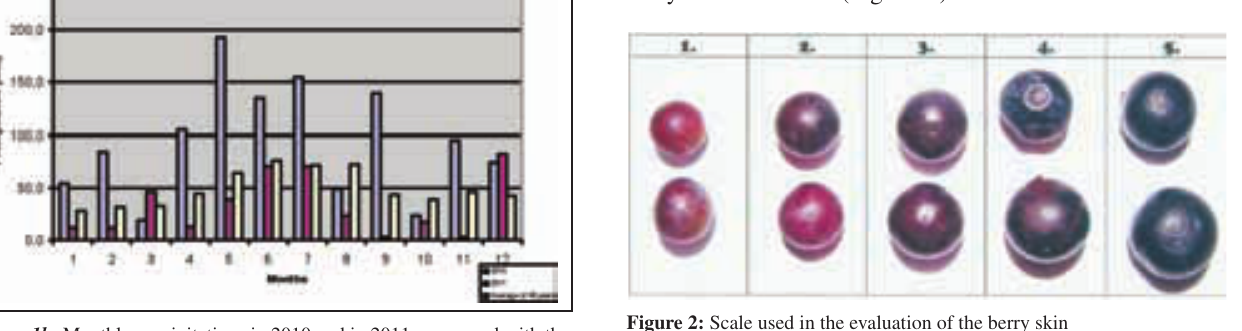
Figure 1b: Monthly precipitations in 2010 and in 2011, compared with the average of 49 previous years